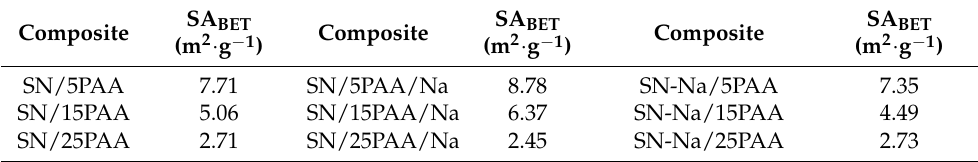
Table 1. Surface area (SA BET ) of SN and SN-Na bentonites and their organic modifications.